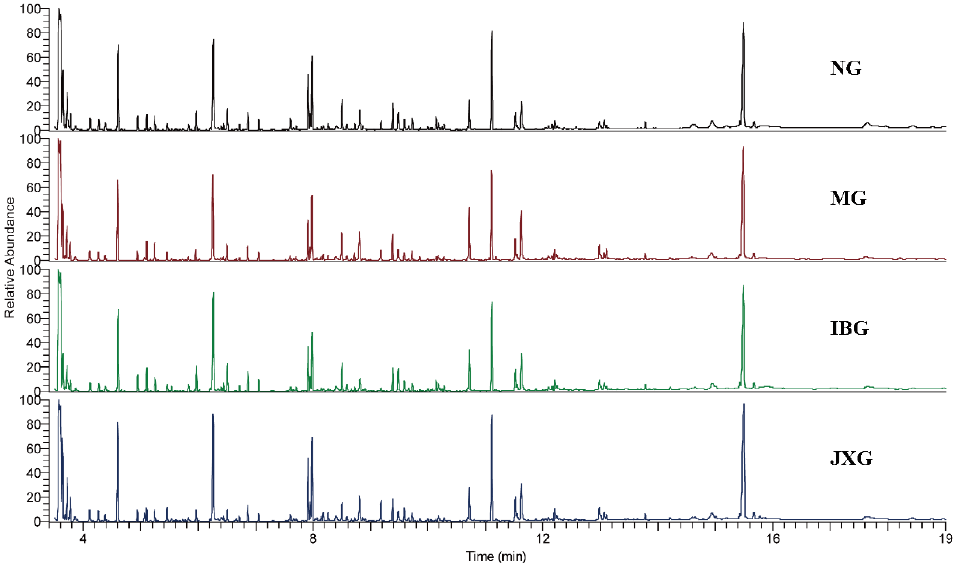
Figure 2. Typical GC-MS total ion chromatograms (TIC) of brain samples from NG, MG, IBG, and JXG.